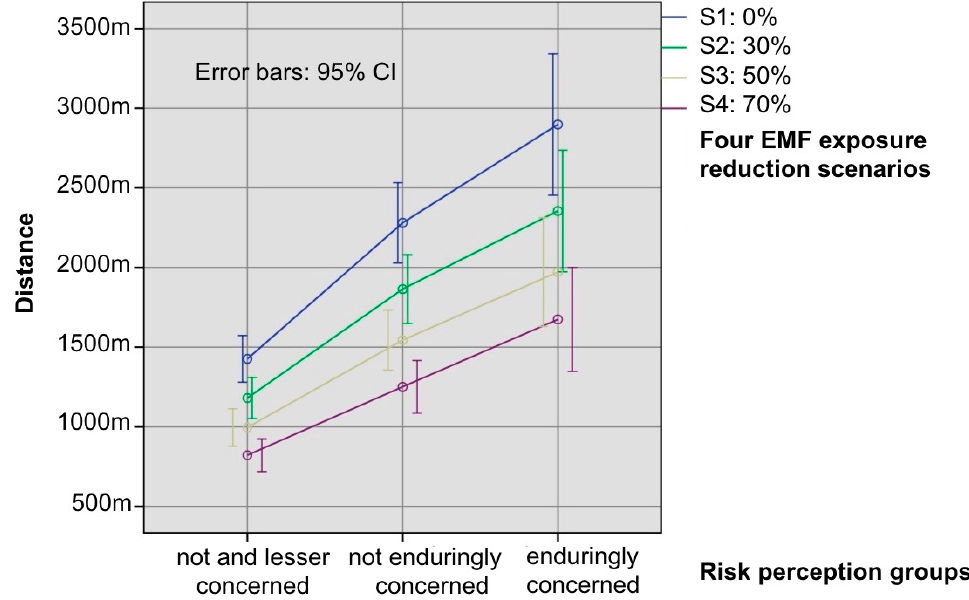
Figure 3. Effect of a reduction in RF EMF exposure on the acceptance of base stations. Provided are the means of requested distances to the next base station, as a function of the risk perception groups. Acceptance measured by the question: “Roughly at what distance (m) would you accept a base station close to your home, if the exposure was reduced by 0%/30%/50%/70%?“. Meaning of lines: blue = 0% exposure reduction, green = 30% exposure reduction, yellow = 50% exposure reduction, violet = 70% exposure reduction. Respondents with distances higher than 10,000 m are excluded. Error bars indicate 95% CI. Table 4 indicates Games–Howell post-hoc tests for differences of accepted distances to the base station between the three risk perception groups for every single exposure reduction scenario.